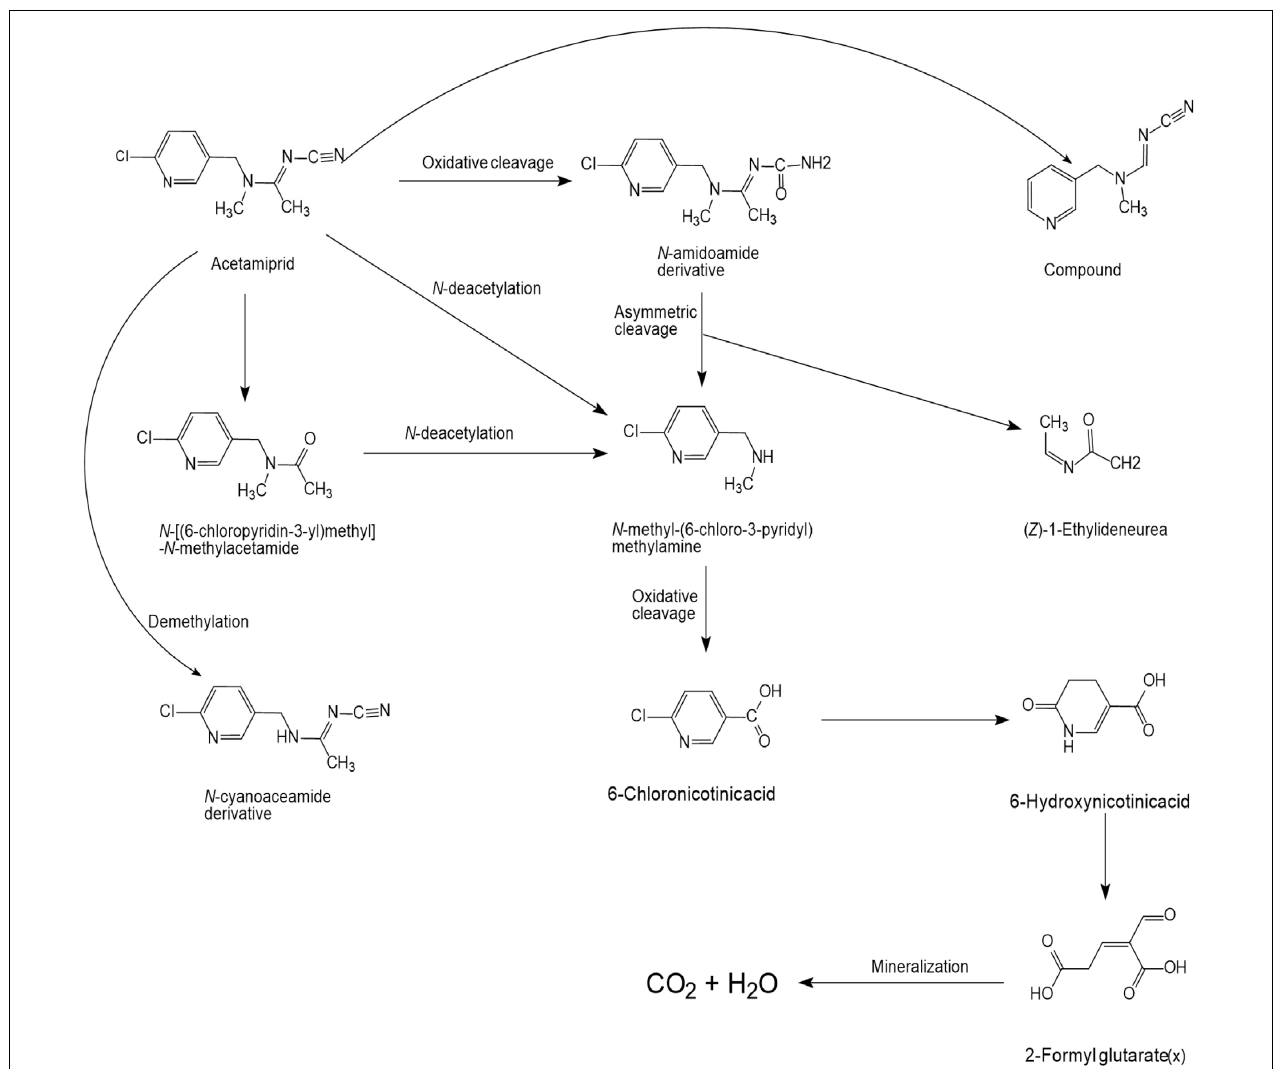
FIGURE 2 | Microbial degradation pathways of acetamiprid (based on Phugare and Jadhav, 2013; Sun S. et al., 2018).